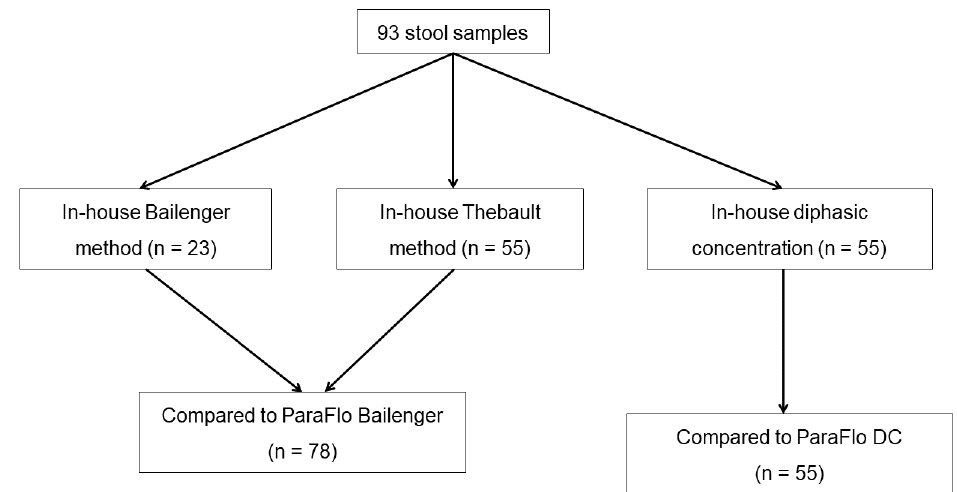
Figure 1. Flowchart of the study design and number of samples analysed.